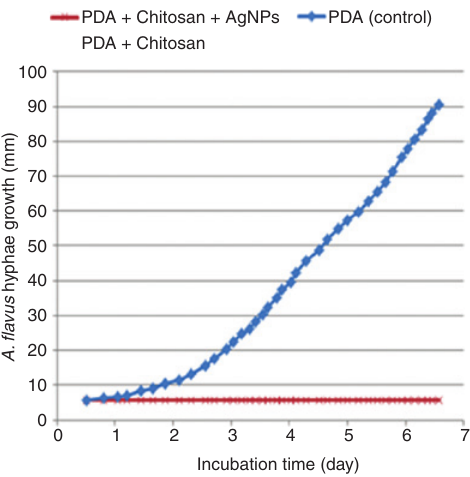
Figure 10: Antifungal effects of the synthesized silver nanoparticles (AgNPs) obtained at optimum conditions on Aspergillus flavus . Data are the mean value of three